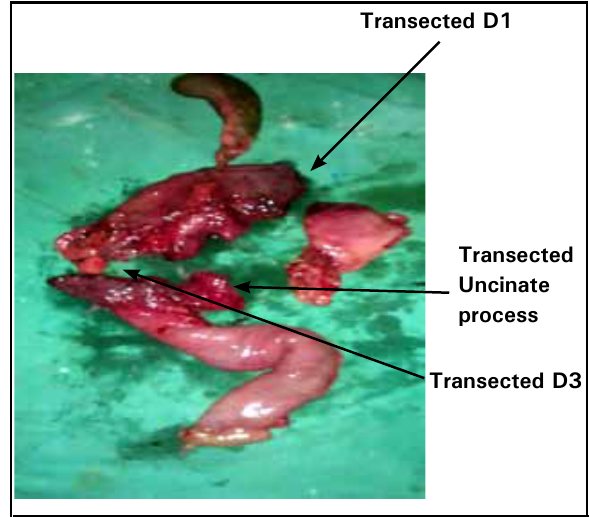
Figure 4. resected